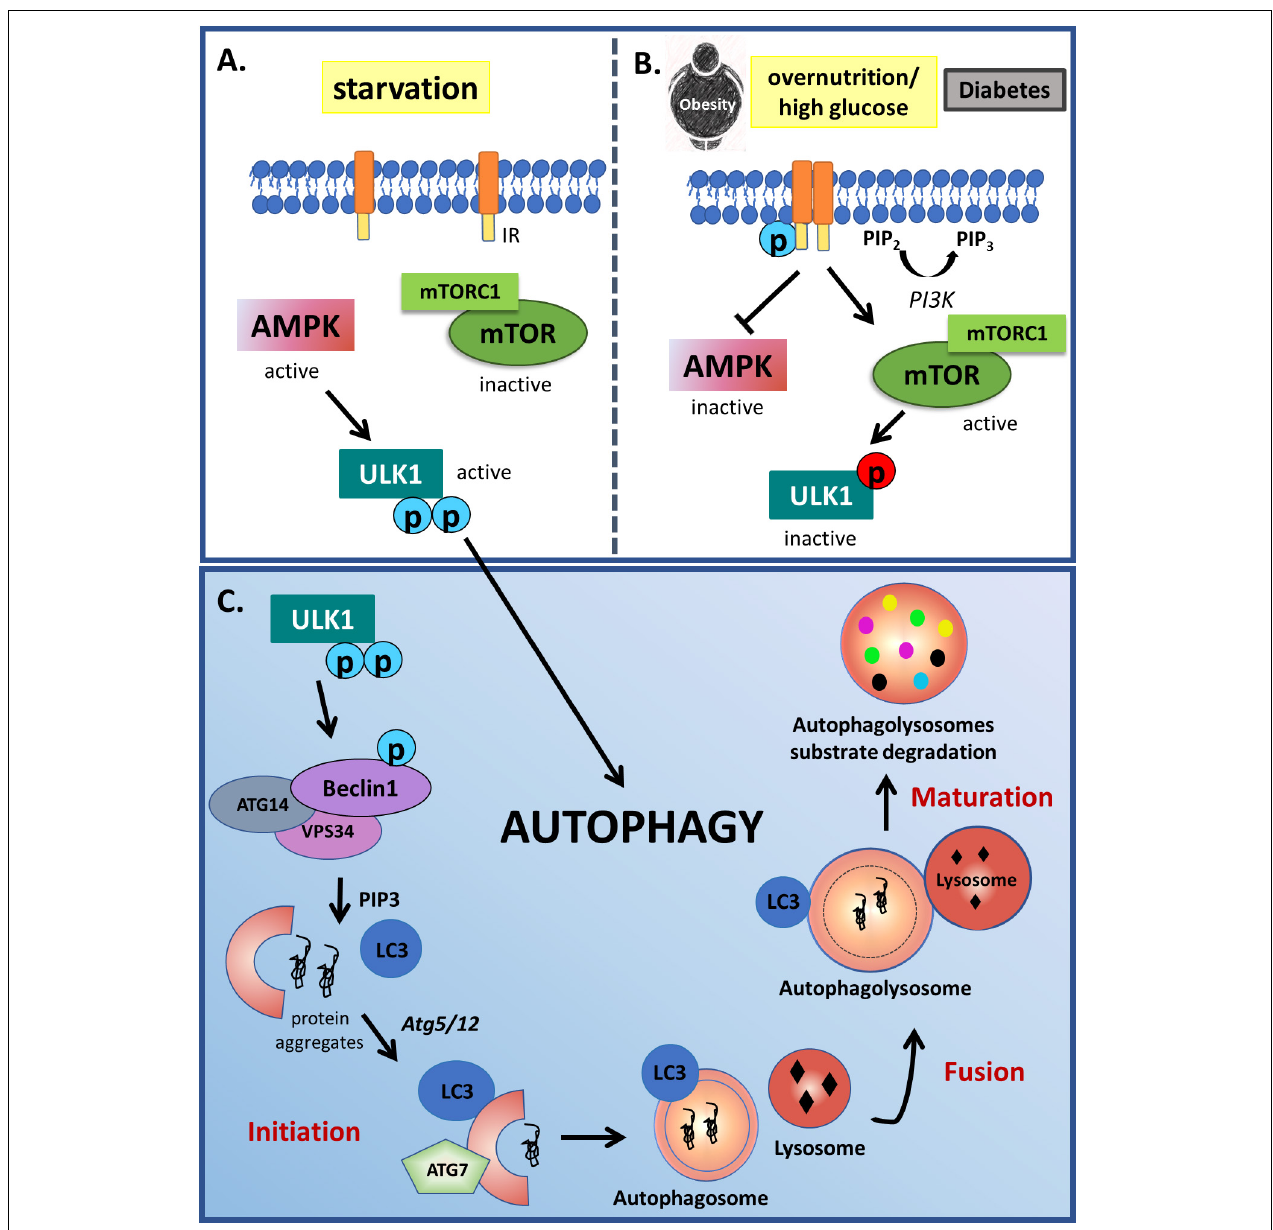
FIGURE 1 | Autophagy modulation by starvation and insulin signaling. (A) Autophagy is classically activated in starvation conditions through ULK1 activity. In low nutrient conditions, AMPK signaling is activated, phosphorylating ULK1 in two different activation sites. Opposite to starvation, (B) in overnutrition condition or diabetes, PI3K type I is activated by growth factor receptors resulting in mTOR activation and AMPK inactivation. mTOR complex TORC1 phosphorylates and inactivates ULK1 (red circles), which is an initiator of mammalian autophagy. (C) During this process, protein-prone aggregates or damaged organelles are engulfed by double membrane structures called autophagosomes, which fuse with lysosomes or vacuoles allowing the degradation of their cargo material in the autophagolysosomes. This complex process starts with ULK1 phosphorylation in 2 different activation residues (indicated by blue circles). Active ULK1 phosphorylates Beclin 1, that together with other components induces the formation of phagophore, an initial membrane component of the isolation membrane, which then expands, curves and closes due to two conjugation pathways dependent of ATG5-ATG12 action to LC3 lipidation, turning into a completed